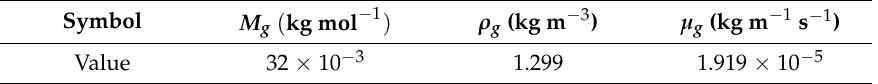
Figure 1. Physical model: ( a ) A vertical electrolysis cell; ( b ) A horizontal electrolysis cell. Table 1. Physical properties of the gas phase flow at T = 25 °C.